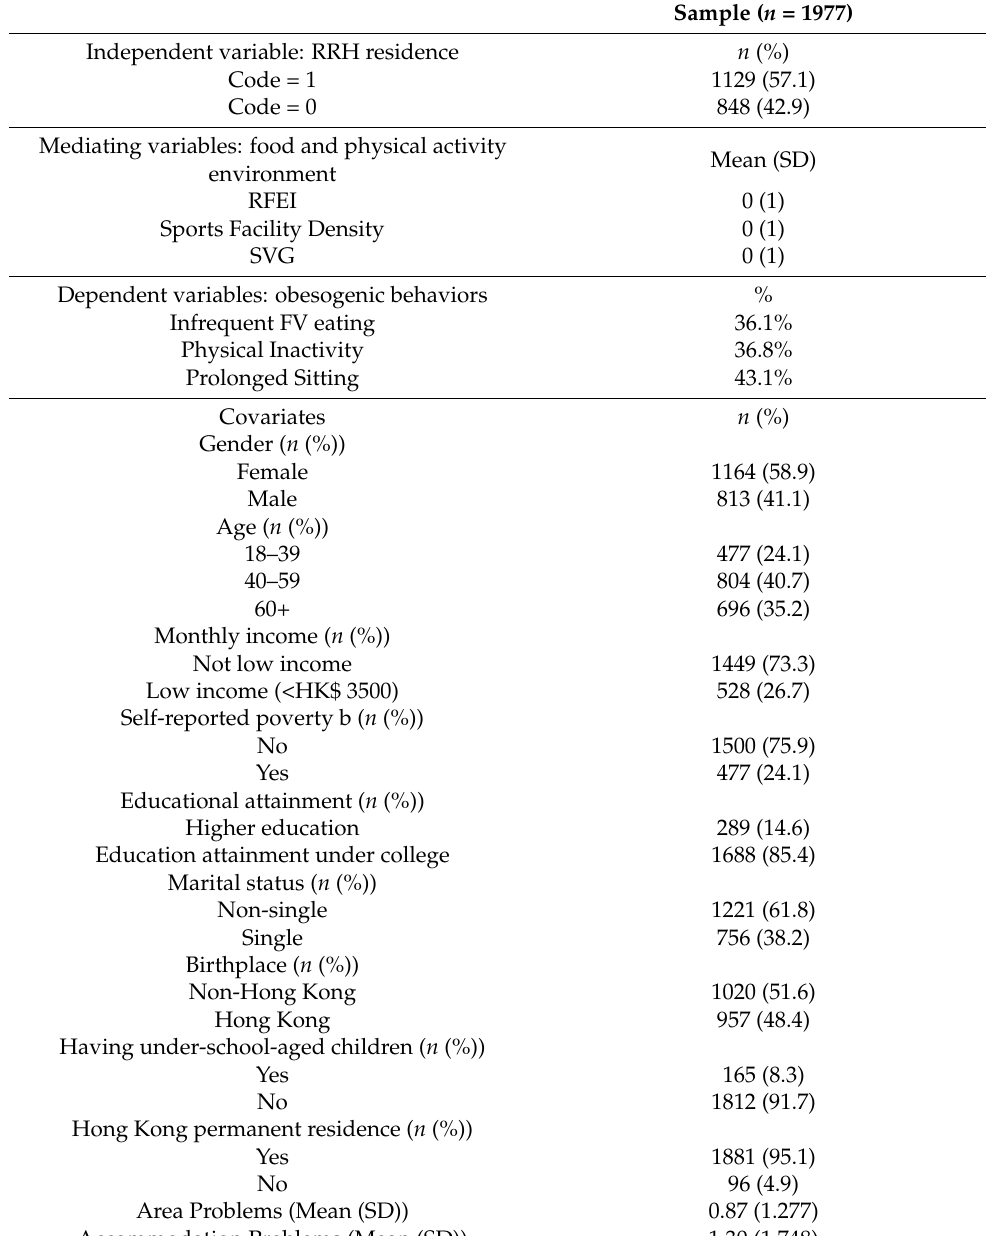
Table 1. Characteristics of participants ( n =